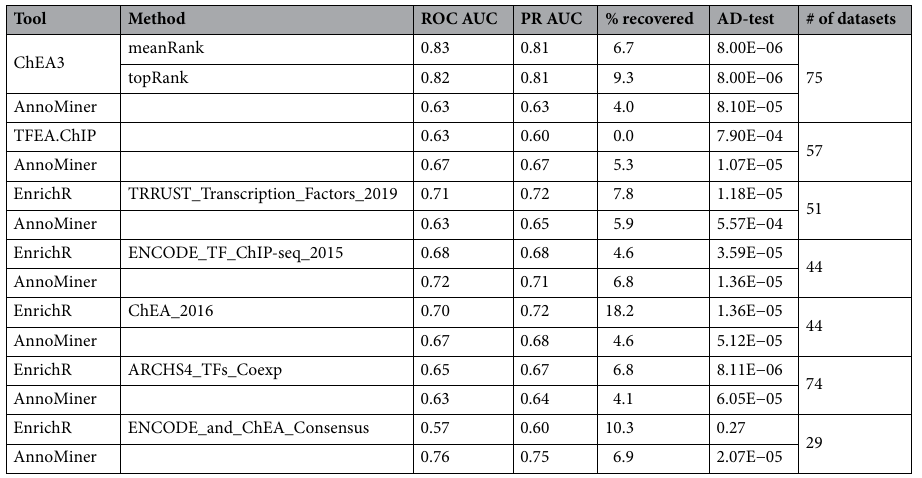
Table 1. Performance values of AnnoMiner compared to other TF enrichment web-tools. AnnoMiner’s metrics are reported only for RefSeq and the parameters: upstream_tss: DynamicRange, downstream_tss:50 bp and overlap:20